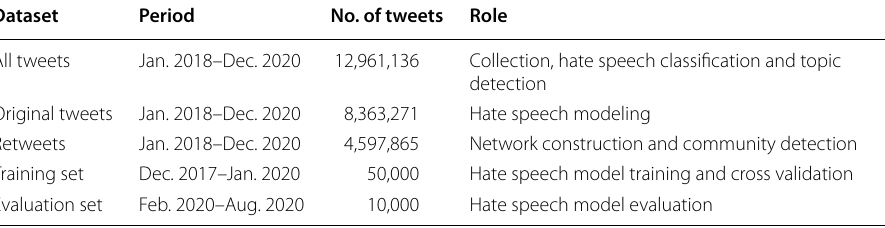
Out of almost 13 million tweets collected, a sample of the original tweets is used for hate speech annotation, training of classification models, and their evaluation. The retweets are used to create retweet networks, and detect communities. All the tweets are automatically classified by the hate speech classification model, and are used to detect topics